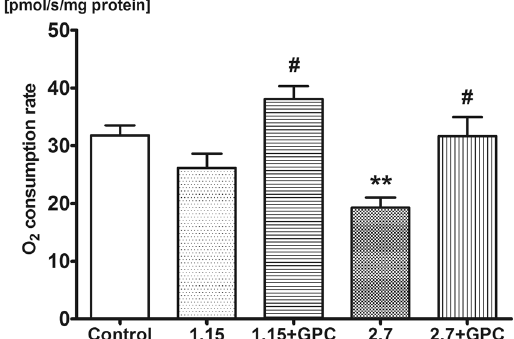
Figure 4. Oxygen consumption of rat liver mitochondria. O 2 consumption rate of mitochondria was assessed in liver homogenate after addition of 0.5 μ M rotenone, 10 mM succinate and 2.5 mM ADP on day 9 of investigation. The 2.7 g/kg/day ethanol-fed group had decreased mitochondrial function compared to control, whereas the GPC treatment prevented the decline of mitochondrial oxygen consumption, demonstrated by higher levels compared to both non-GPC treated ethanol-fed groups. Mean values and standard error of mean (SEM) are given; ** p < 0.01 vs . Control, # p < 0.05 vs . corresponding GPC-treated groups. Statistics: One-way ANOVA with Bonferroni post-hoc test.